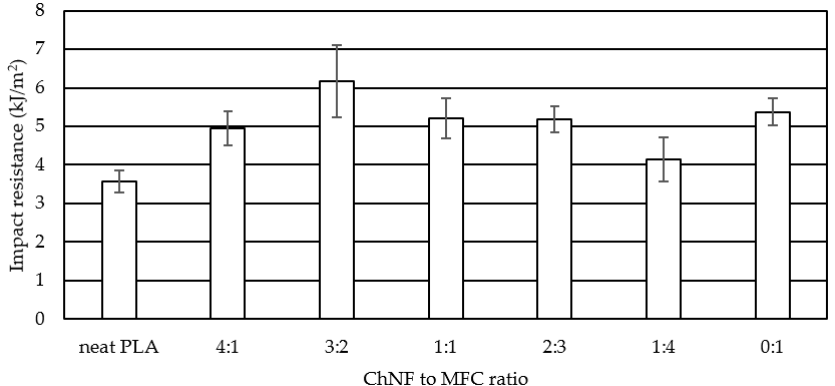
Figure 7. Notched impact resistance of nanocomposites with 50 wt % reinforcing phase with varying chitin nanofiber (ChNF) to microfibrillated cellulose (MFC) ratios.